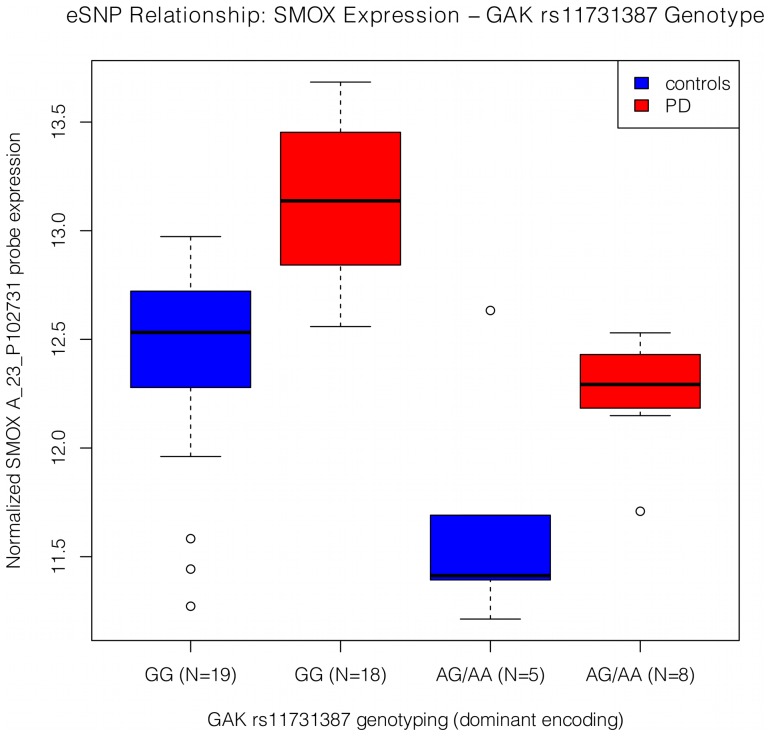
Expression by genotype relationship between the SMOX probe, A_23_P102731, and the GAK SNP, rs11731387.The box whiskers extend to the most extreme data point, which is at most 1.5 times the interquartile range from the box. The result for the 2-degree of freedom test was p = 8.1E-6, and the eSNP relationship was stronger in PD (p = 7.47E-5, beta = −0.727) than in controls (p = 0.037, beta = −0.494). The minor allele frequency for rs11731387 in the used brain sample was 0.15, and the odds ratio for this SNP in the additive model affection study of the meta-GWAS was 1.35.